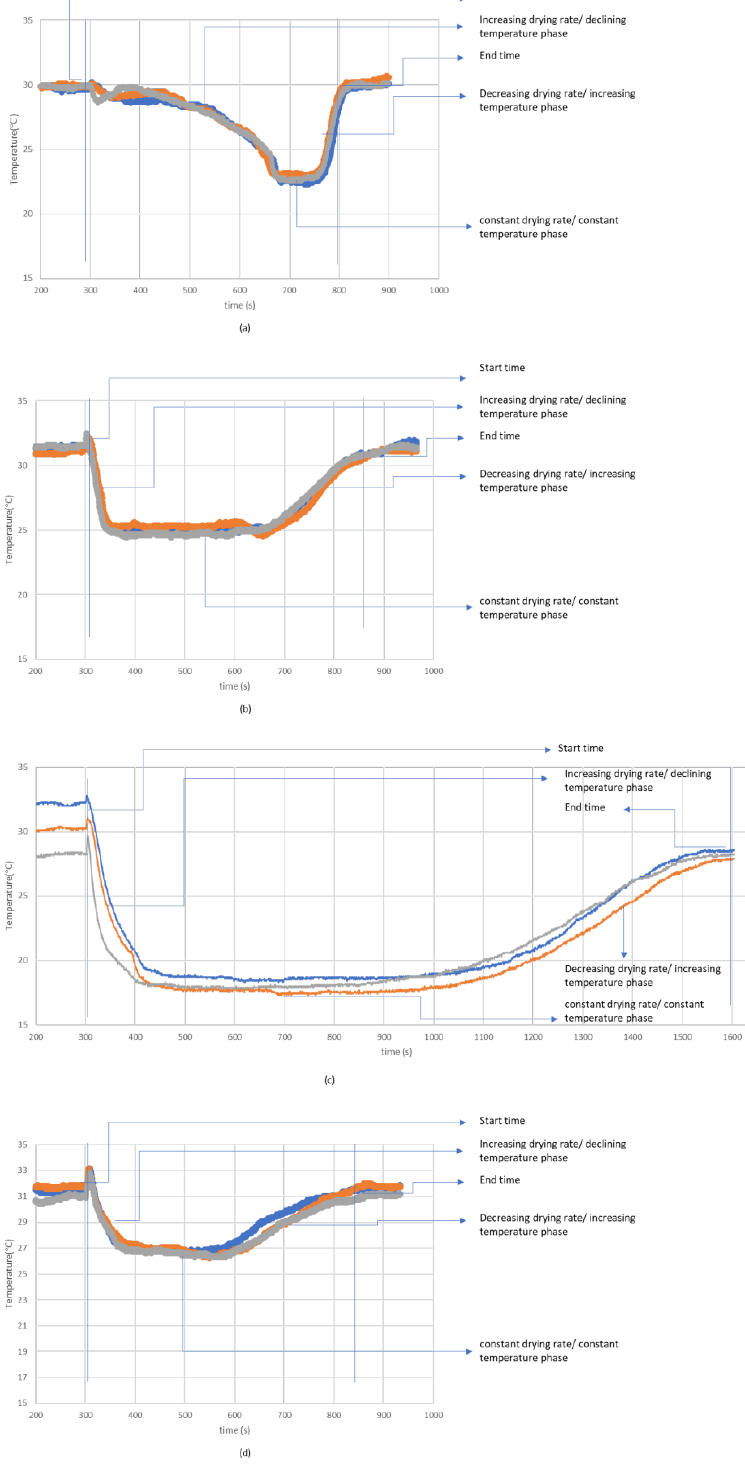
Figure 3. Temperature time plotting for drying rates of different samples ( a – d ). Each color identifies different trials of the same